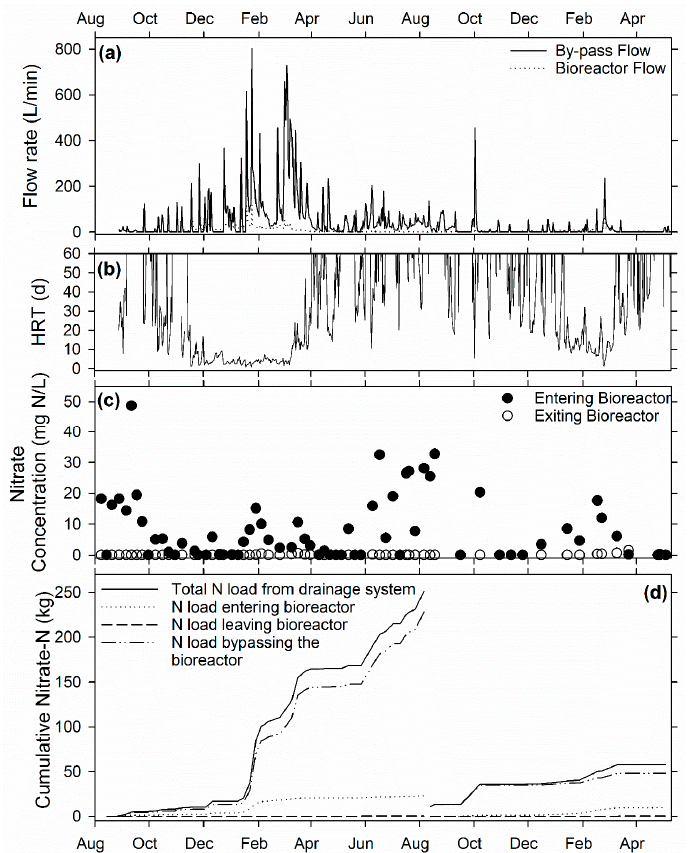
Figure 3. Ridgley Farm bioreactor and ( a ) bypass flow rate; ( b ) hydraulic retention time (HRT); ( c ) inflow and outflow nitrate concentrations; and ( d ) nitrate loadings from August 2014 to May 2016. Loadings reflect the annual periods from the start of monitoring .